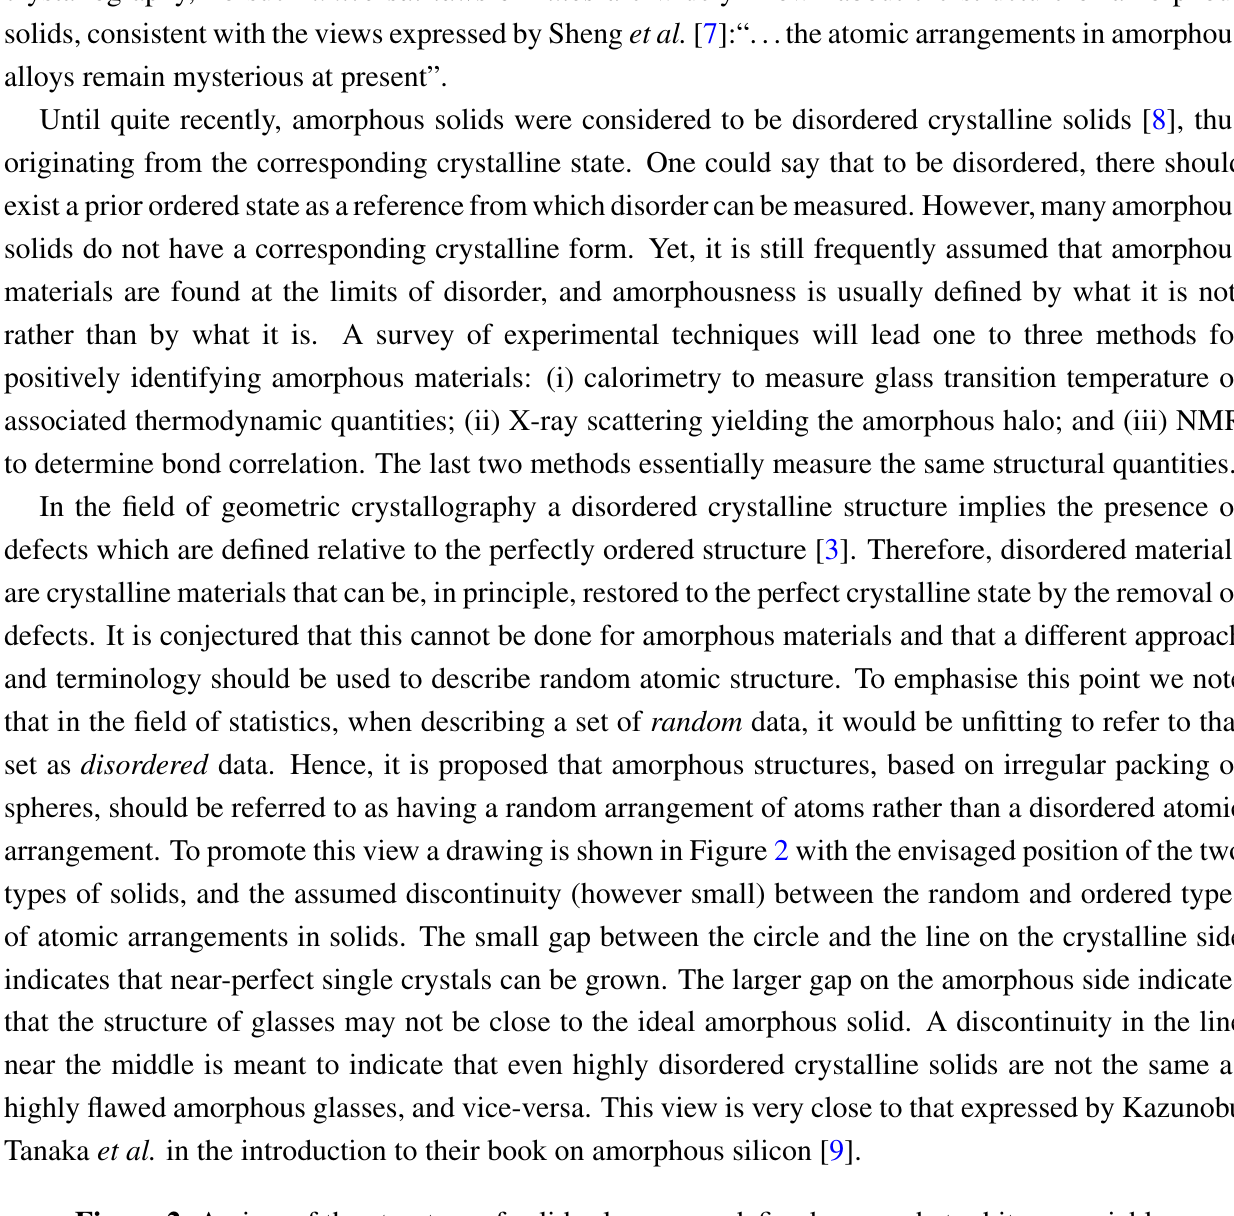
Figure 2. A view of the structure of solids along an undefined, somewhat arbitrary variable. The circles indicate the positions of the ideal (perfect) structures; the lines indicate the spectrum of structures in real